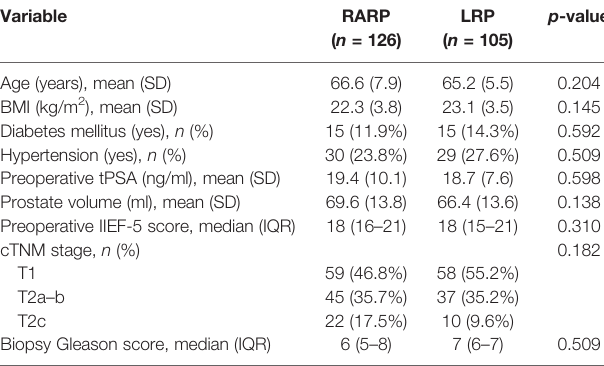
TABLE 1 | Preoperative characteristics by surgery